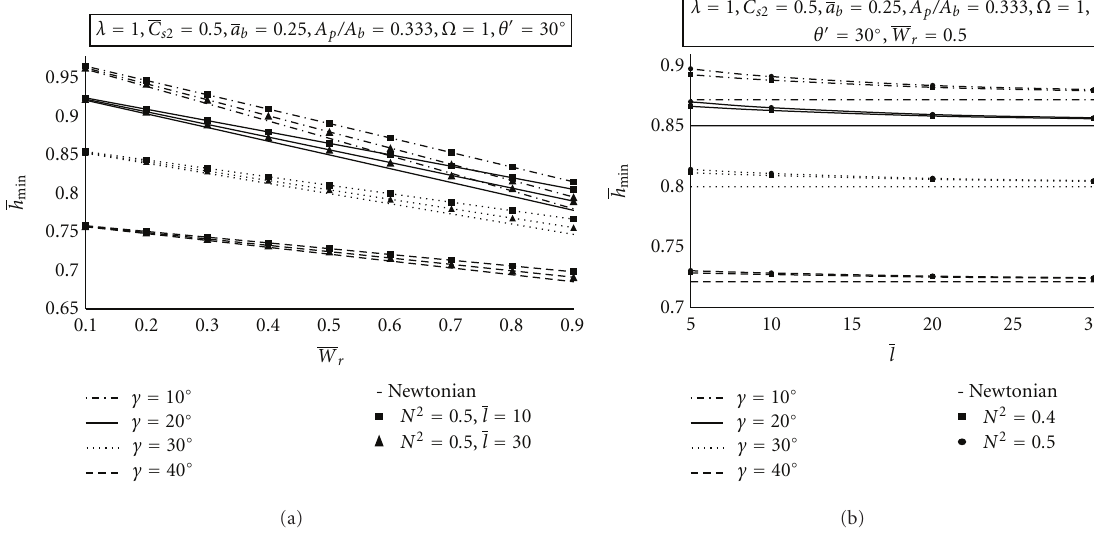
Figure 7: (a) Variation of minimum fluid film thickness ( h min ) versus radial load ( W r ). (b) Variation of minimum fluid film thickness ( h min ) versus characteristic length ( l ).